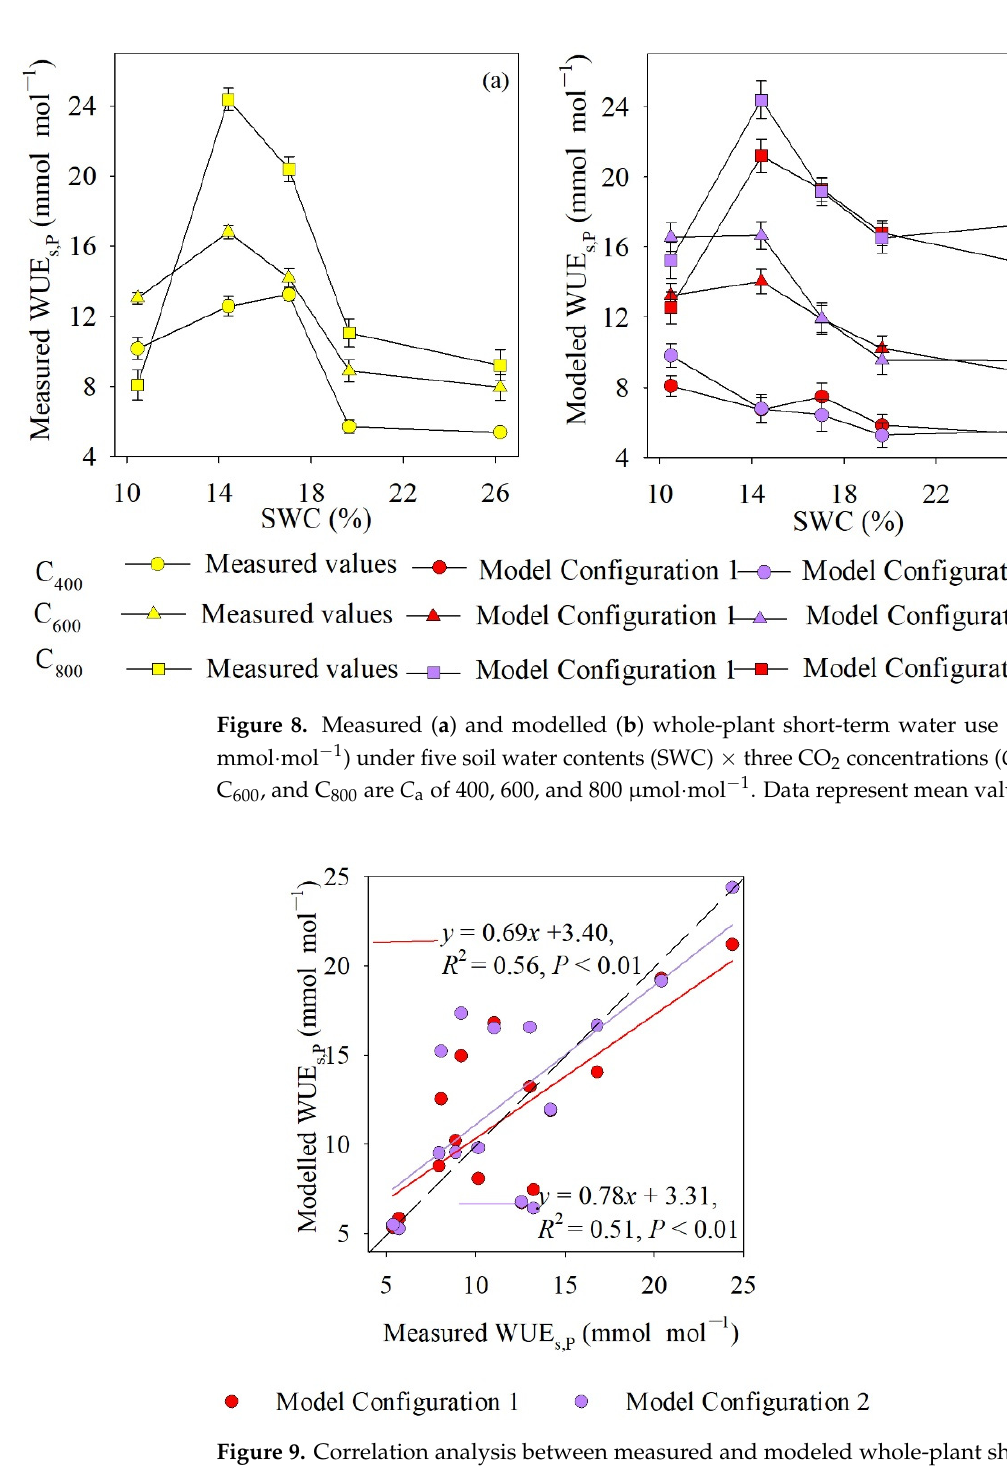
Figure 9. Correlation analysis between measured and modeled whole-plant short-term water use efficiency (WUE s,P , mmol·mol − 1 ) estimated by different model configurations.